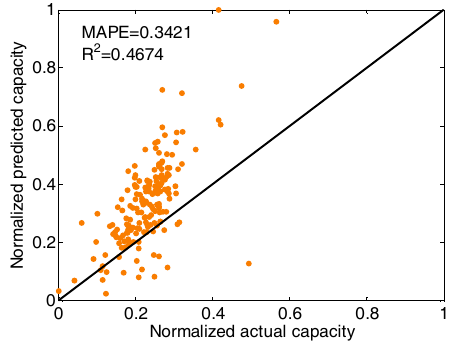
Figure 10. The estimation results of the method proposed in the literature [16].